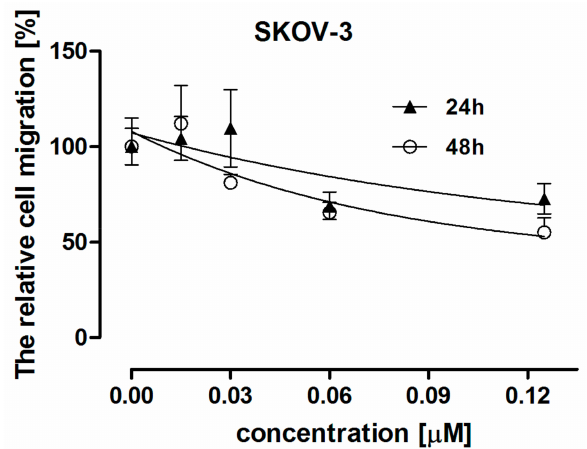
Figure 2. The cell migration after 12- and 24 h treatment of SKOV-3 cell line with DMU-214 at concentrations range 0.00–0.125 µ M. The relative cell migration was determined by comparing to the control cells. The data are the mean ±